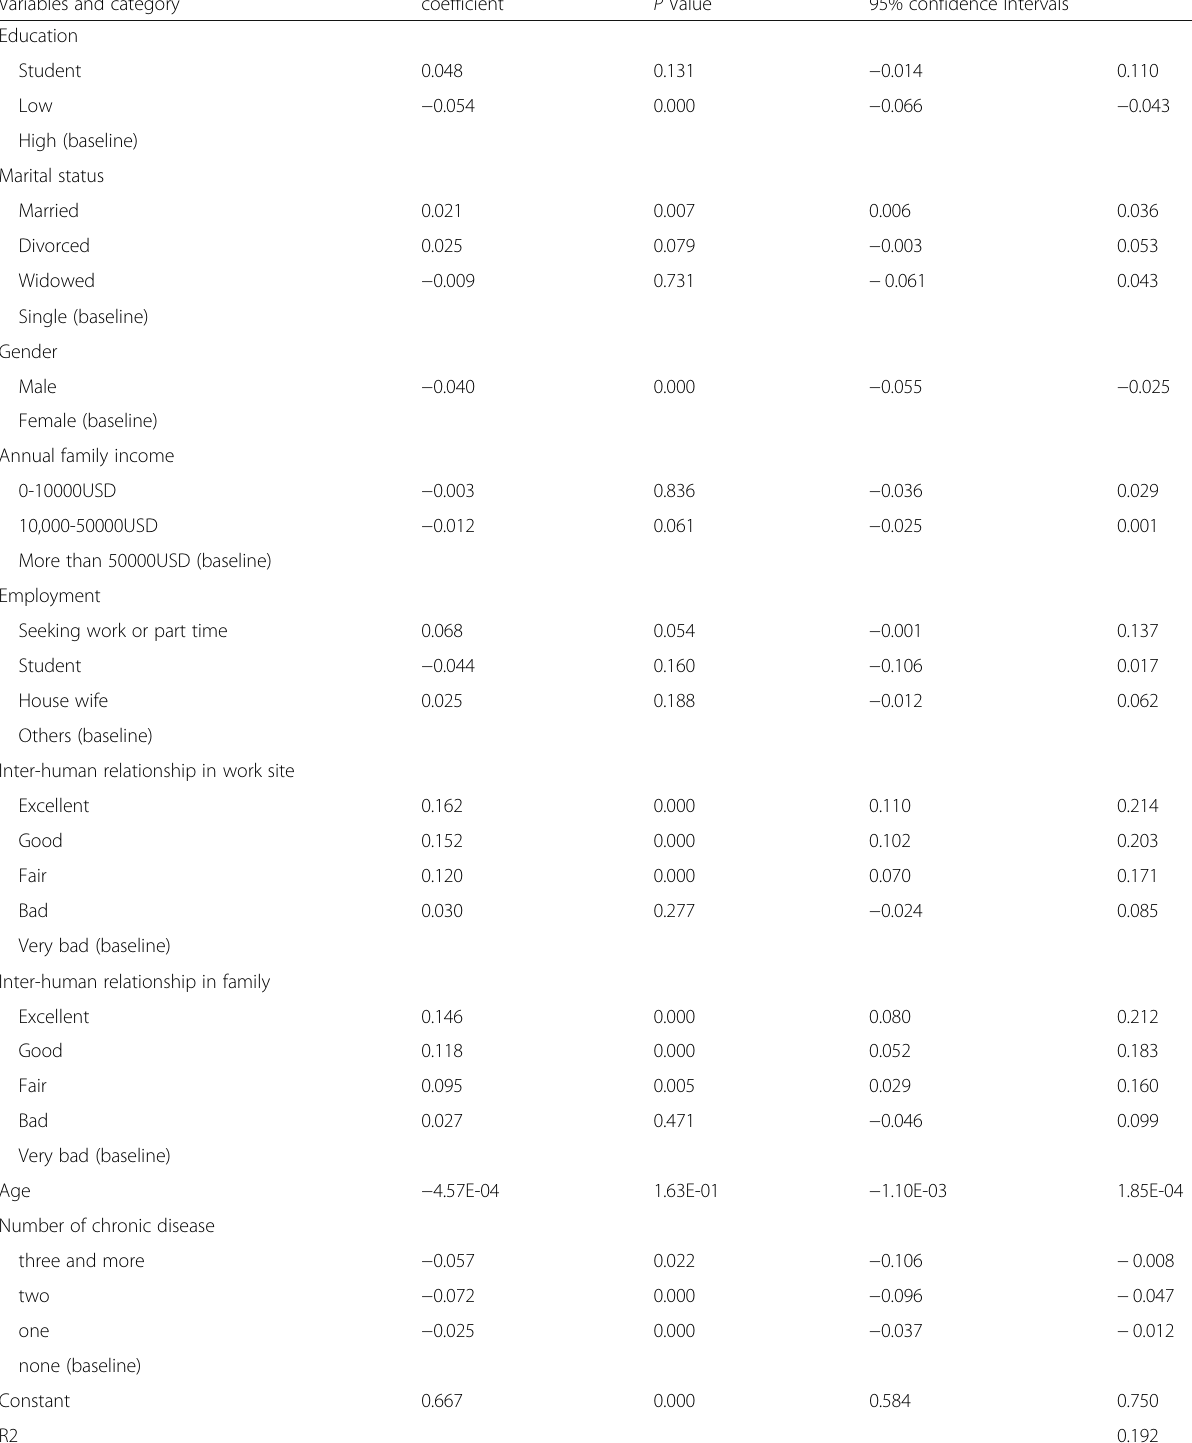
Table 6 Linear regression estimates for model of multiattribute global HUI3 utility score as a function of personal characteristic